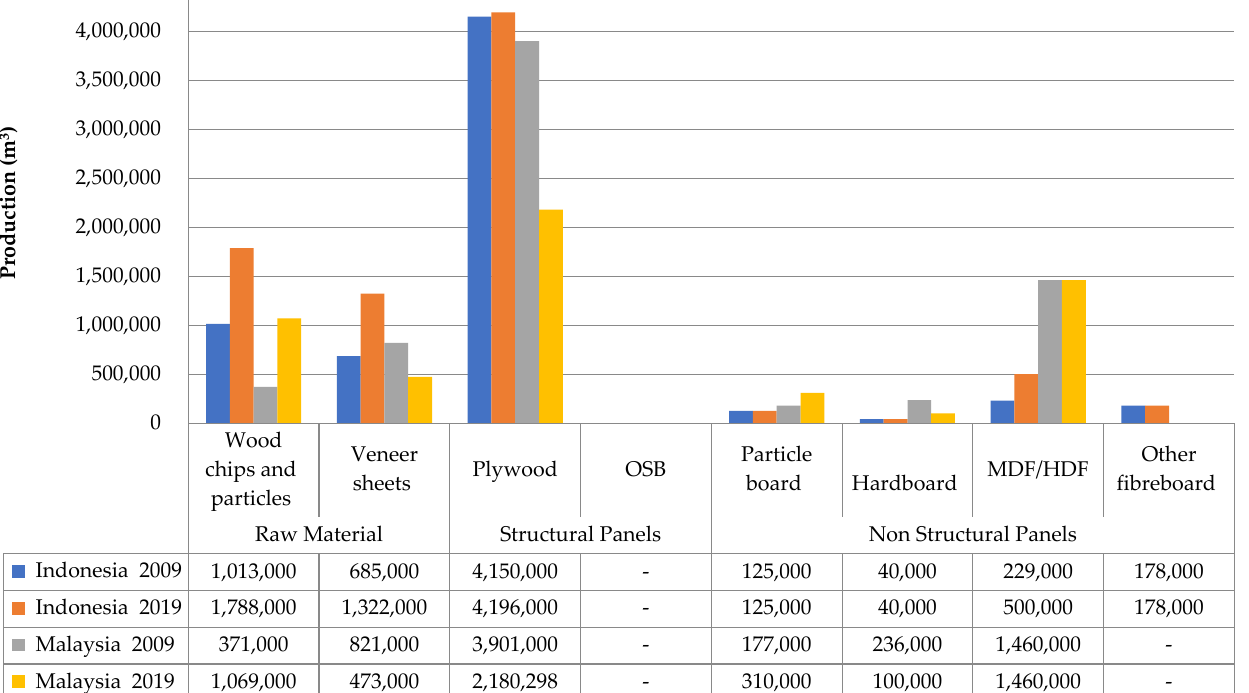
Figure 4. Data production of wood-based panels of Indonesia and Malaysia in a decade (2009–2019) consisting of raw material (wood chips and particles and veneer sheets), structural panels (plywood & OSB), and non-structural panels (particleboard and fiberboard) [12].